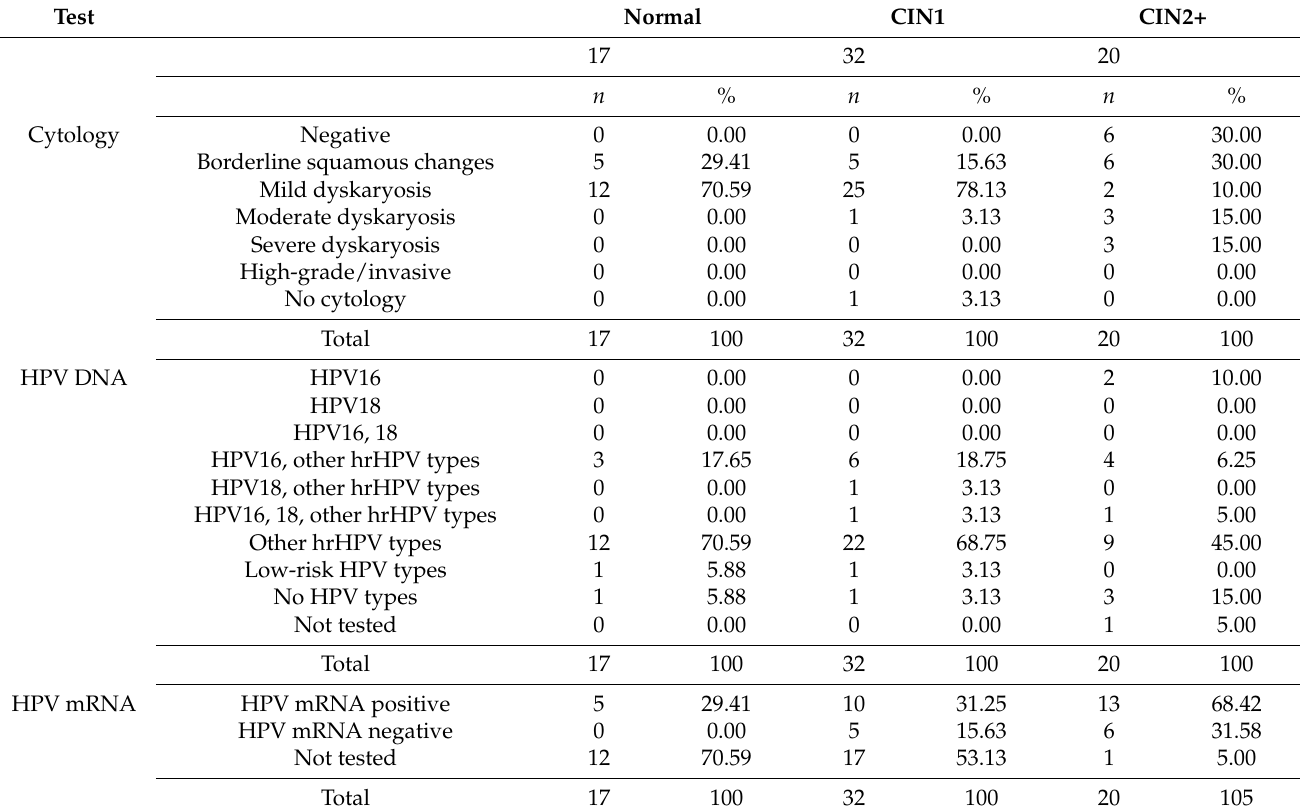
Table 3. Summary of test set of samples, including cytology, HPV DNA and HPV mRNA